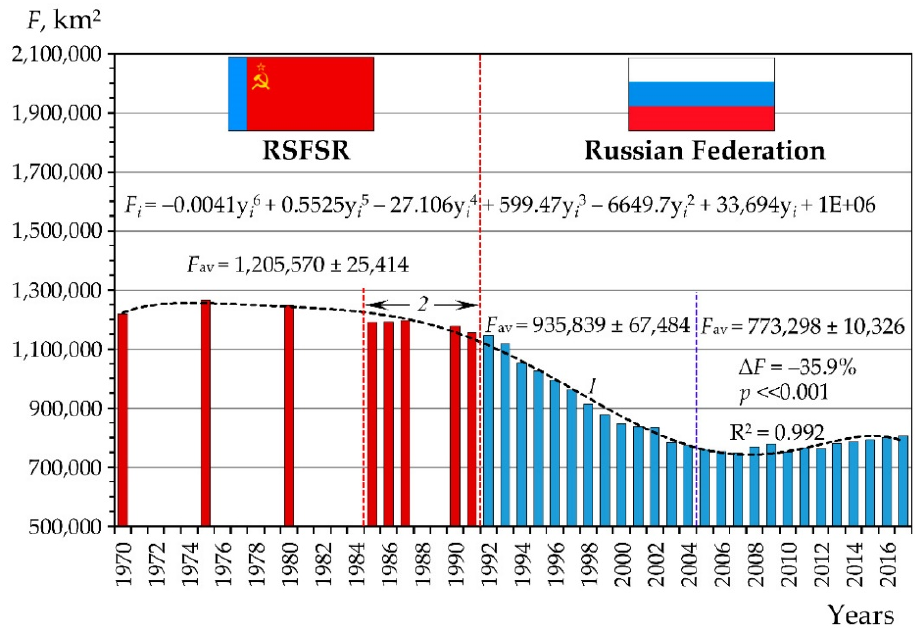
Figure 1. Change in the total area of cultivated land ( F ) in the Russian Federation in 1970–2017. RSFSR—the Russian Soviet Federative Socialist Republic as the principal part of the former USSR until December 1991; F av —the average area of cultivated land; ∆ F —relative change in F av between 1970–1991 and 2005–2017 with p (Student’s t -test); R 2 —the coefficient of determination of a sixth-degree polynomial trend ( 1) ; 2 —the years of the political and economic reform in the USSR, “Perestroika”. In the sixth-degree polynomial equation: F i is the modeled F- value for the year y i . Note. According to the five-year program for the development of the socialist planned economy of the former USSR, the total area of cultivated land during every five years (…1971–1975, 1976–1980, 1981–1985, and 1986–1990) remained slightly changed.